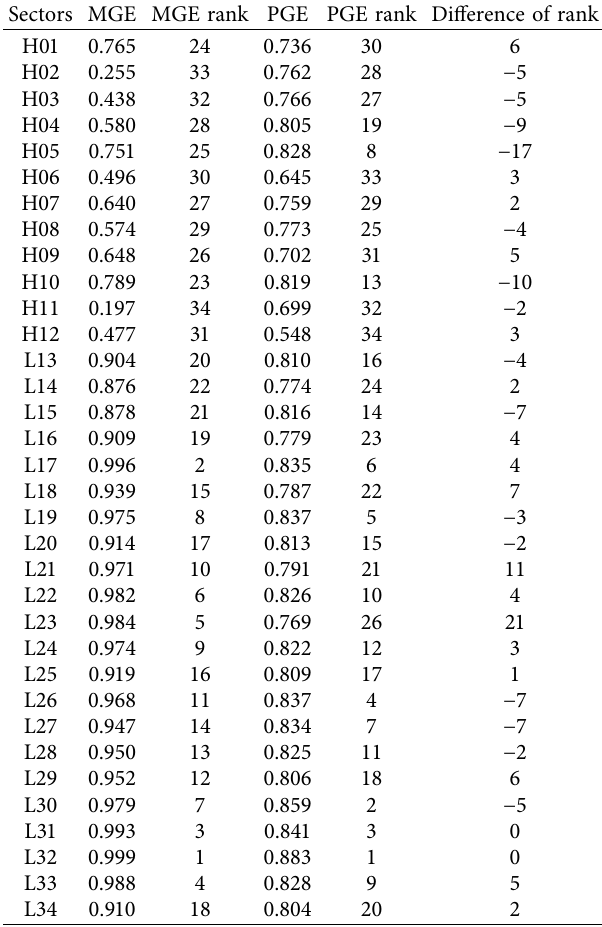
Table 8: Comparison of rankings of metafrontier and pooled green efficiency. Sectors MGE MGE rank PGE PGE rank Difference of